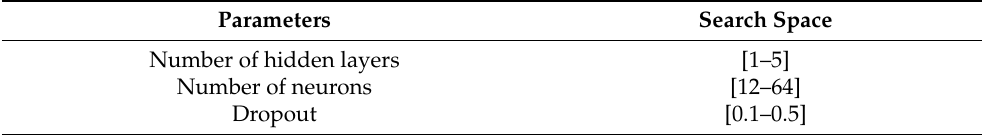
Table 4. Hyperparameter optimization–Search space.